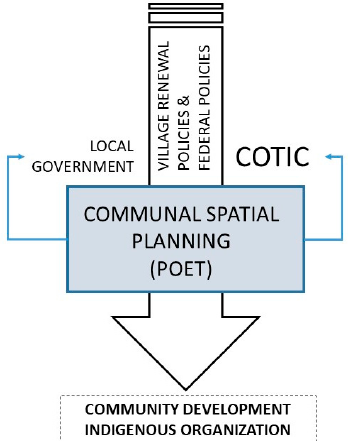
Figure 4. Transversal framework for village renewal policies in Cuetzalan. Source: Schumacher (2020).